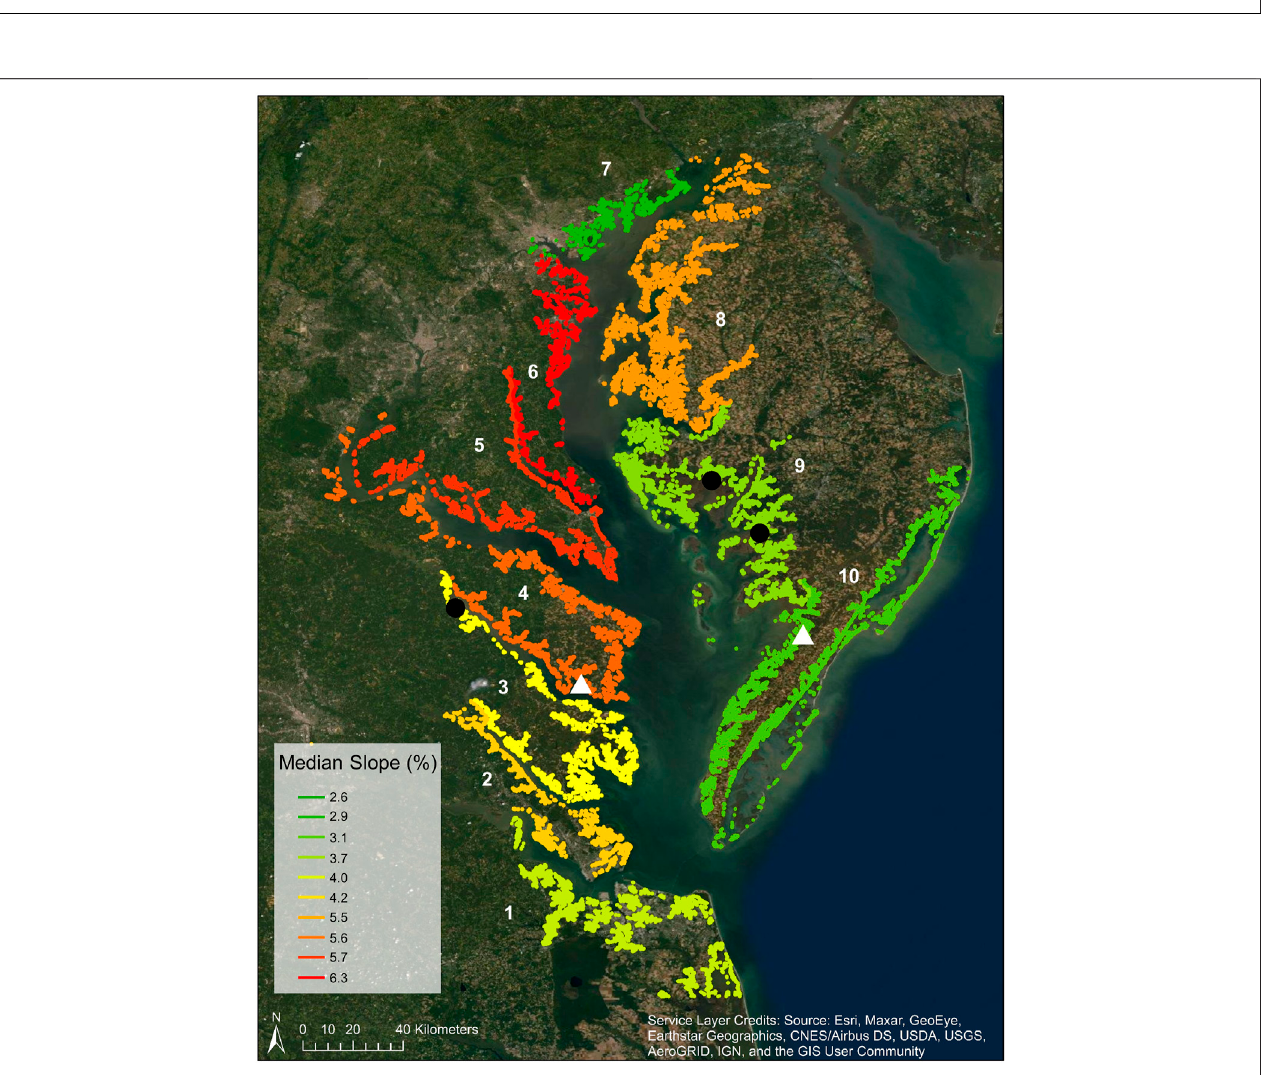
Frontiers in Environmental Science |